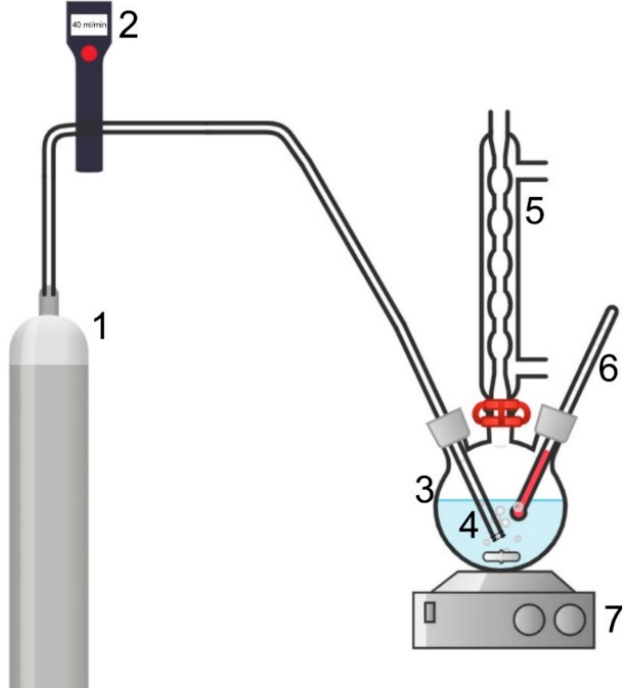
Figure 11. Apparatus used in the oxidation of α -pinene with oxygen: 1—oxygen cylinder, 2—oxygen flow regulator, 3—glass reactor with the capacity of 50 cm 3 , 4—glass bubbler for oxygen supply, 5—reflux condenser, 6—thermometer, 7—magnetic stirrer with heating function.